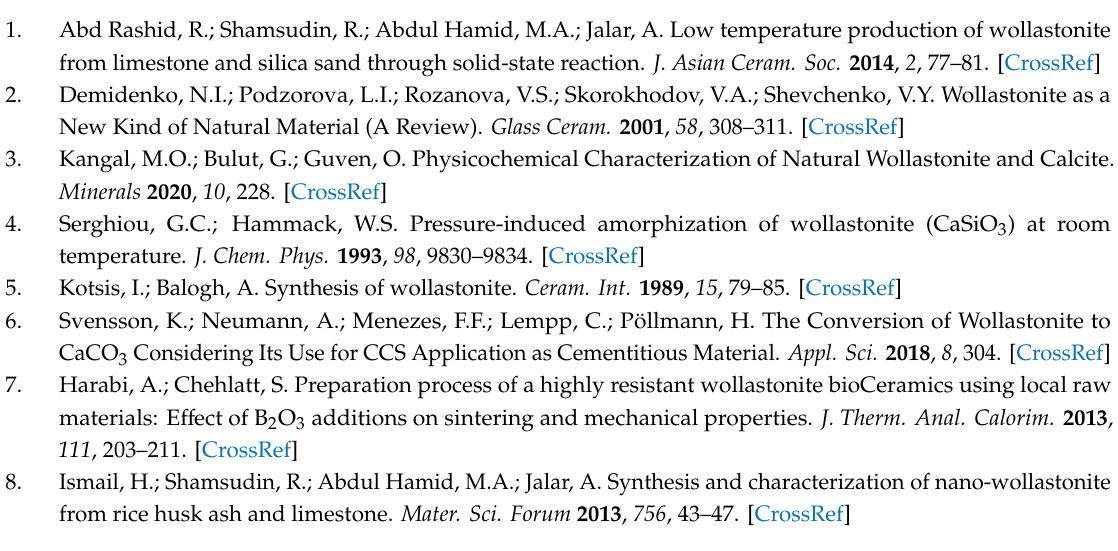
Figure 7. Solution energy of MO 2 (M = Ge, Ti, Sn, Zr and Ce) with respect to the M 4+ ionic radius.